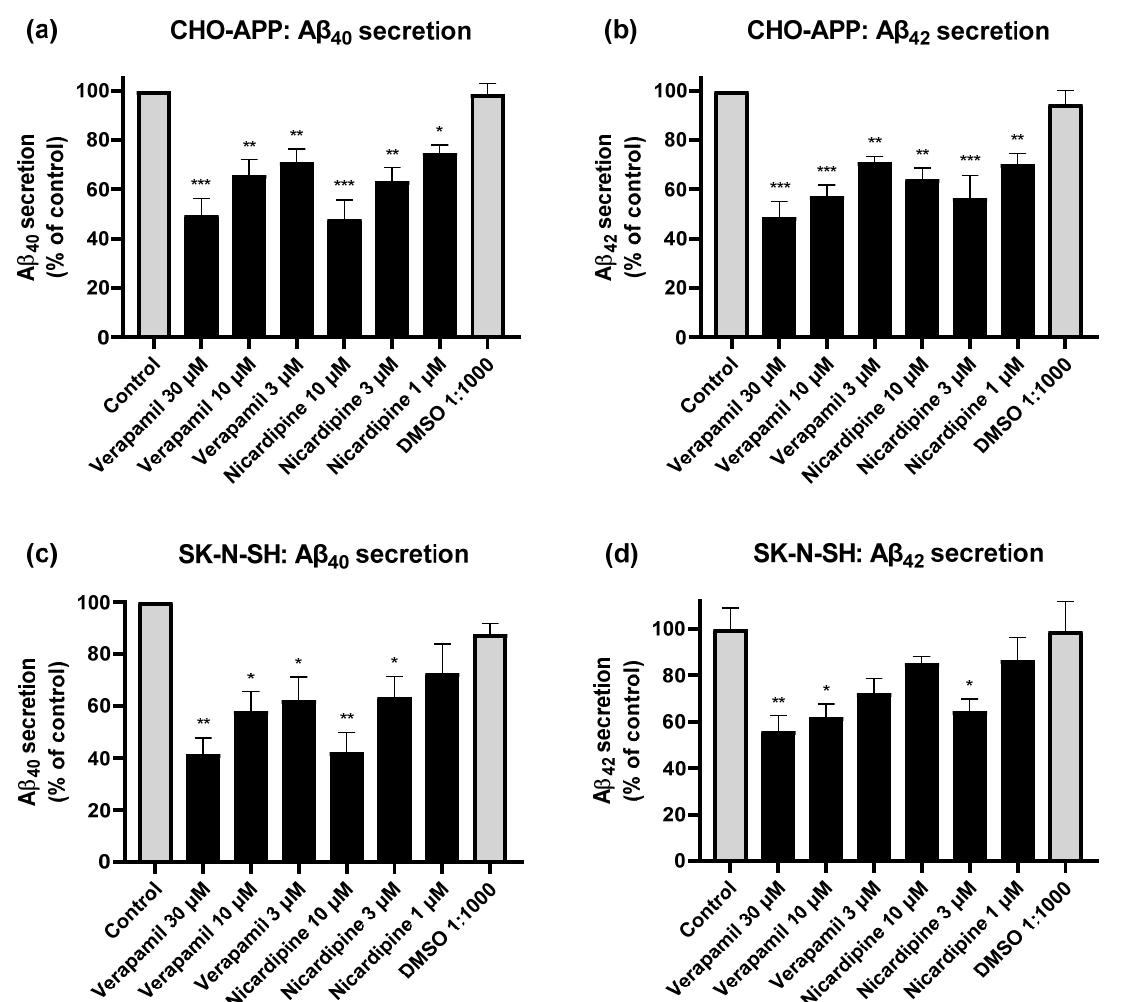
Figure 6. Inhibition of P-gp reduces A β efflux from CHO-APP and SK-N-SH cells. CHO-APP cells were treated with verapamil, nicardipine, or DMSO, or left untreated, for 24 h before supernatant was collected and analysed for ( a ) A β 40 and ( b ) A β 42 content by in-house ELISA. Data are displayed as mean ± SEM of three independent experiments for each peptide, and were adjusted for protein concentration. Each experiment was conducted with three biological replicates, each with additional three technical replicates. SK-N-SH cells were similarly treated and analysed for ( c ) A β 40 (mean ± SEM, n = 2) and ( d ) A β 42 (mean ± SEM of one experiment run in triplicate cultures) secretion into media but using commercial ELISA kits. * p ≤ 0.05, ** p ≤ 0.01, *** p ≤ 0.001.